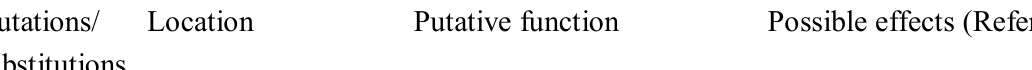
Table 1. Mutations in genomic segments and proteins of attenuated Mopeia (MOP)/LAS reassortant, clone ML29